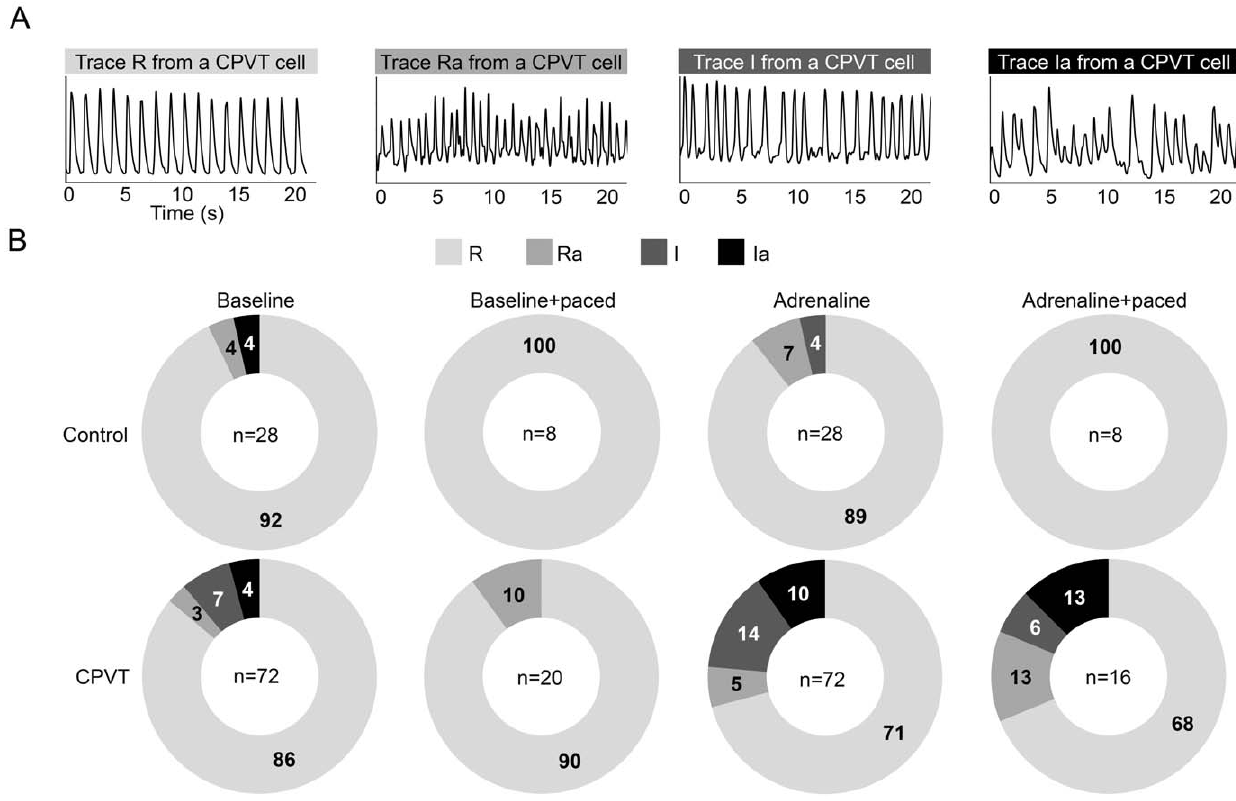
Figure 3. Intracellular Ca 2 + cycling and analysis of rhythm. A , representative traces of the four different rhythm categories. Regular rhythm of calcium release with stable amplitude R, regular rhythm with varying amplitude Ra, irregular rhythm with stable amplitude I, irregular rhythm with varying amplitude Ia. B , doughnut charts indicating the percentage of CPVT and control CMs under each rhythm category.